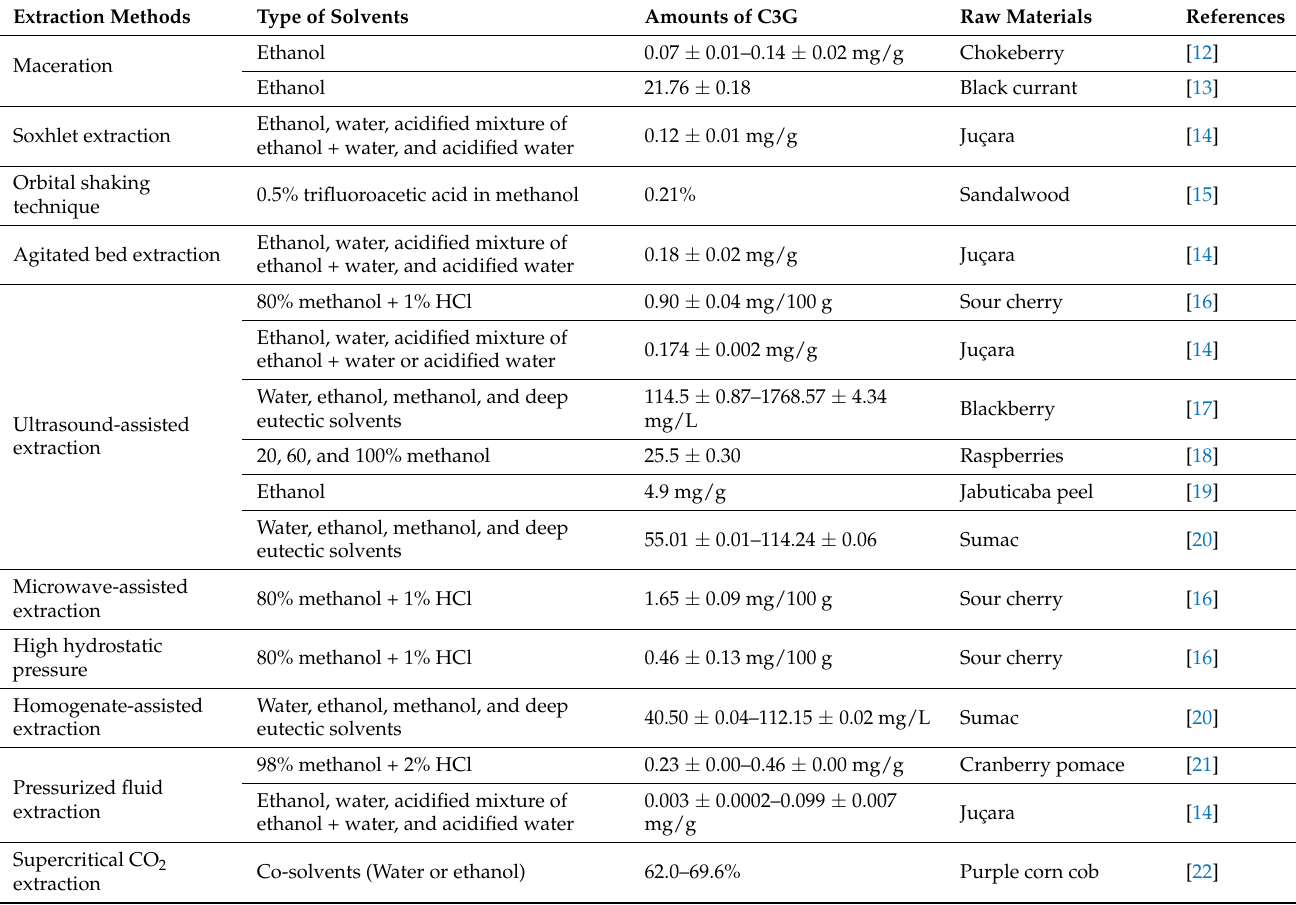
Table 2. Recovery of cyanidin 3- O -glucoside by different extraction